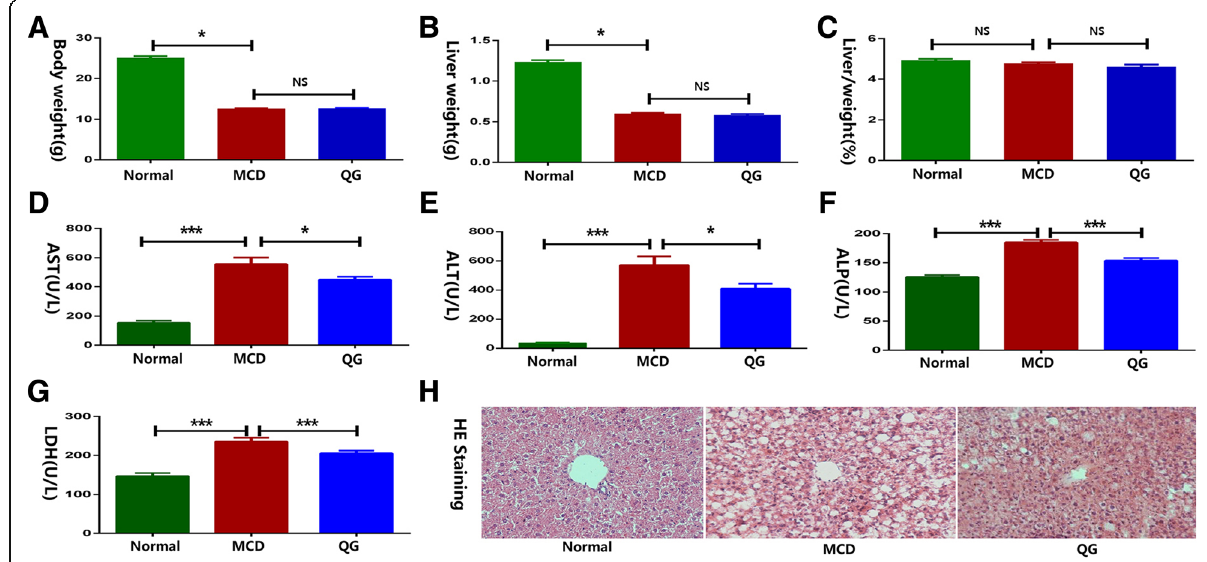
Fig. 1 Phenotypic characteristics of the mice. a Body weight. b Liver weight. c Liver/body weight ratio. d Serum AST. e Serum ALT. f Serum ALP. g Serum LDH. h Liver sections stained with H&E. Data were represented as mean ± SD, n = 12 per group, a P < 0.05, b P <